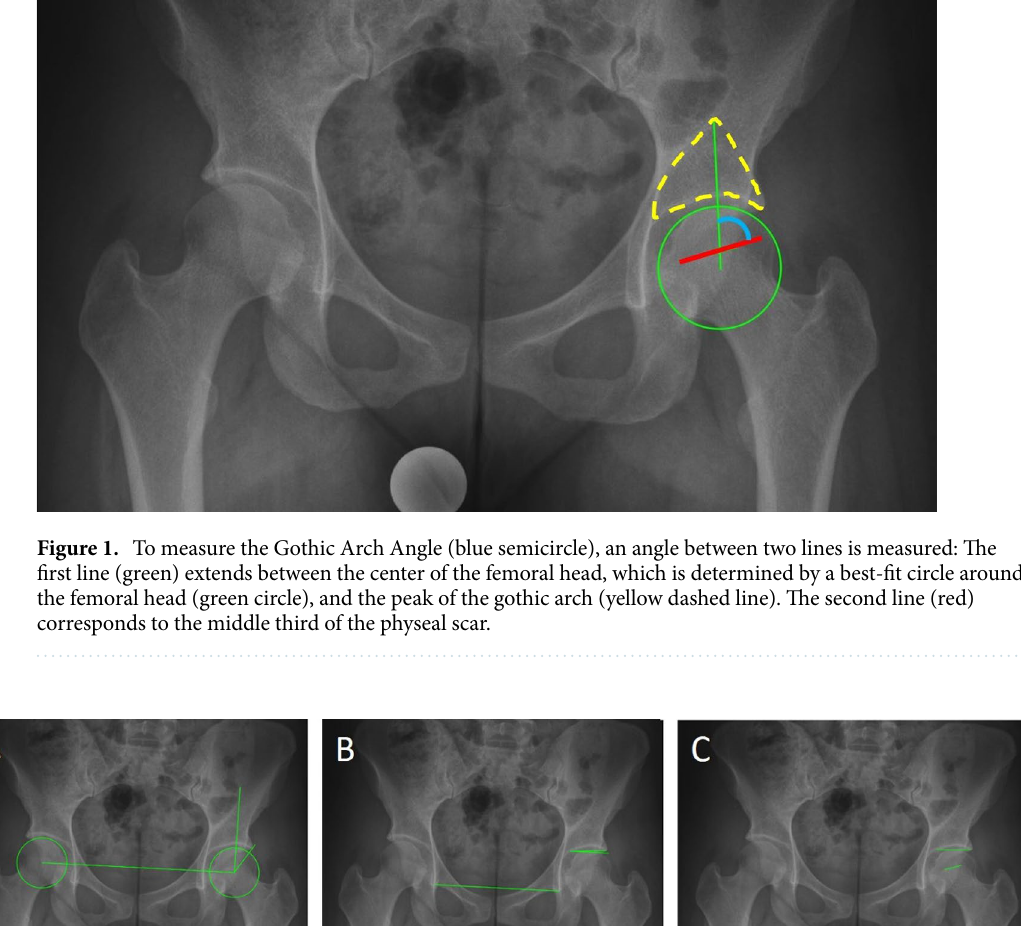
sis were performed using standard receiver operating characteristic (ROC) curves to determine optimal cutoff values. The threshold for statistical significance was set to 0.05.